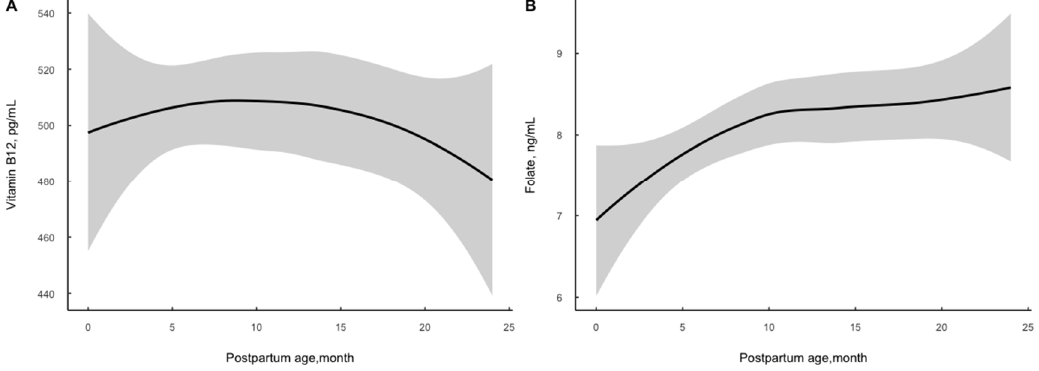
Figure 1. Distribution of serum vitamin B12 ( A ) and folate ( B ) concentration by postpartum age among 982 women. Table 2. The adjusted association of the relevant variables with vitamin B12 and folate concentrations by multiple regression model.